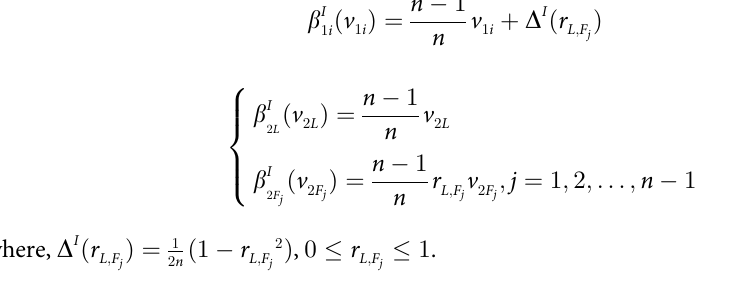
Table 1. Summary of parameter symbols and meanings. Symbols for